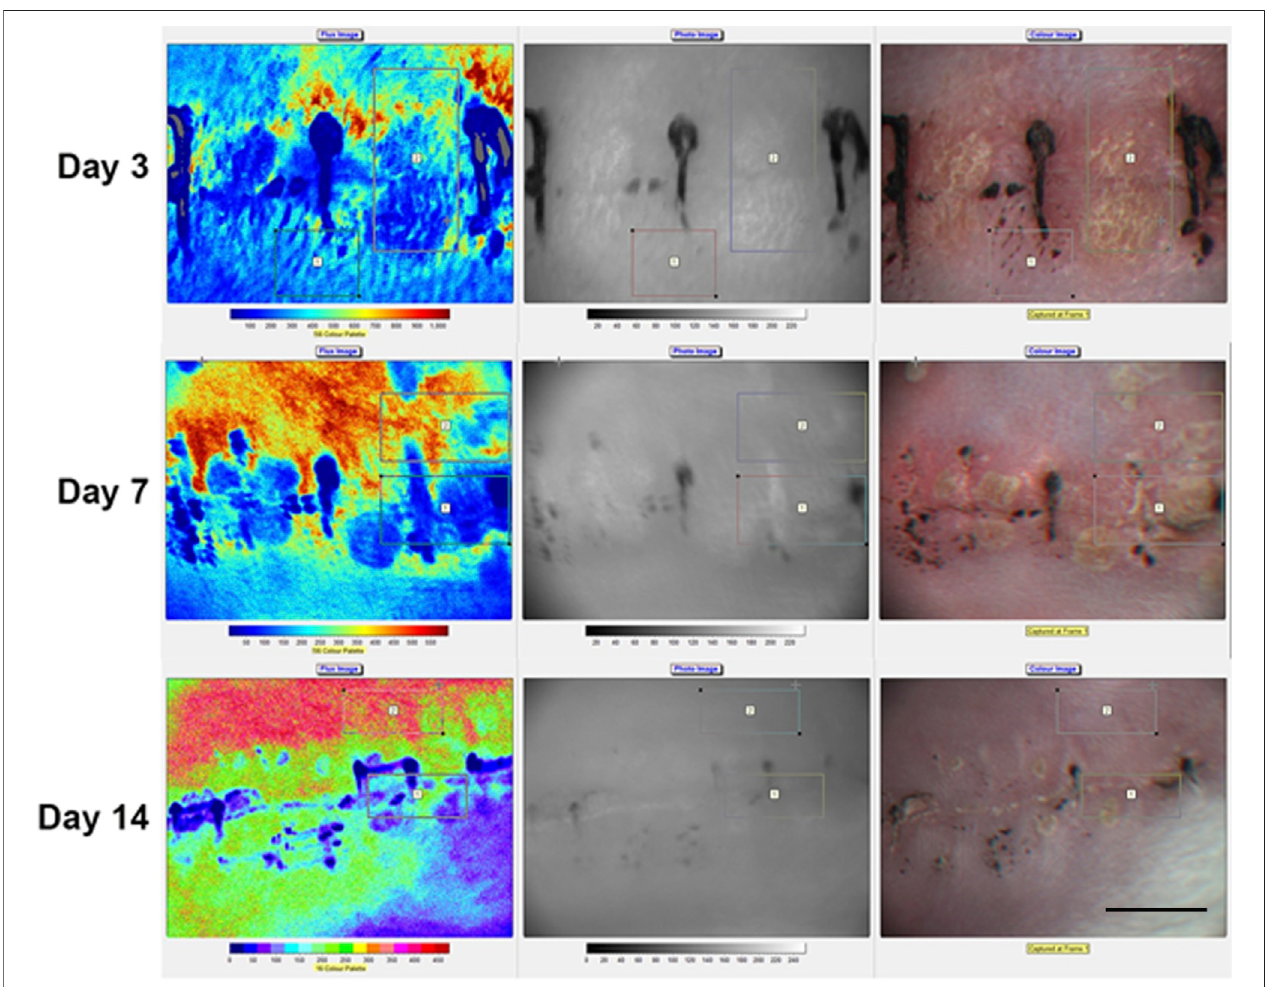
FIGURE 1 | Local blood perfusion in rabbit back skin incisional wounds. By using Moor FLPI-2 full- fi eld Laser Perfusion Imager localized blood perfusion was imagedintherabbitbackskinincisionalwoundsondays3,7and14.Anincreaseinbloodperfusioncanbeseenfromday7onwards(representedbyyellowandorange colors). Scale bar is 10